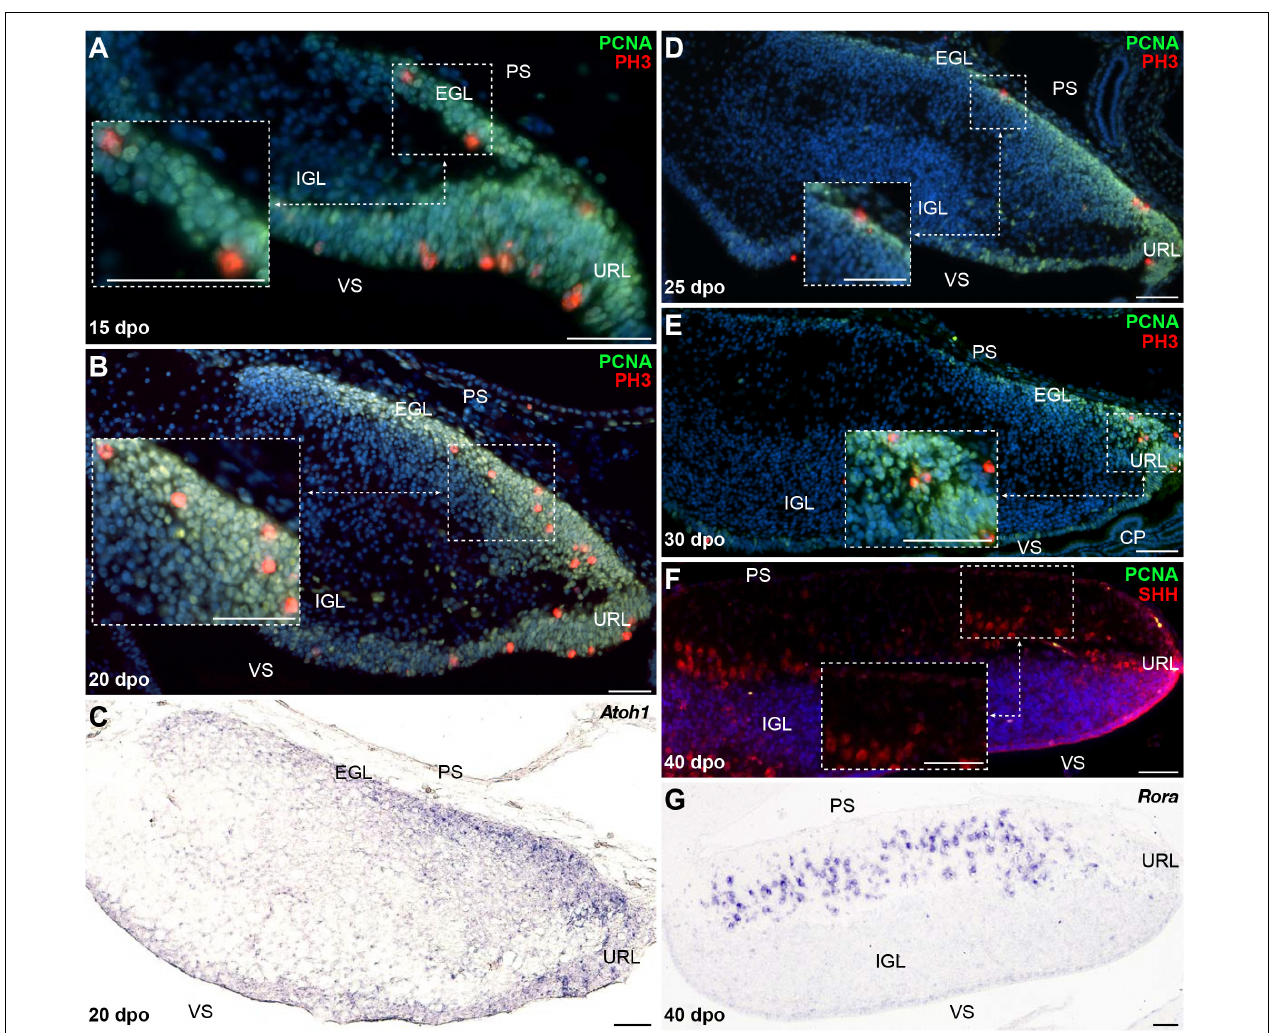
FIGURE 5 | Molecular characterization of GC patterning in B. fuliginosus . (A–E) Double IHC for PCNA (green staining) and PH3 (red) markers (A,B,D,E) or ISH for Atoh1 (C) at various indicated embryonic developmental stages between 15 and 30 dpo in the cerebellum of B. fuliginosus . Insets in panels (A,B,D,E) show high magnifications of mitotic progenitors on the pial surface. (F,G) Double IHC for PCNA (green) and SHH [ (F) ; red] or ISH for Rora (G) at 40 dpo. The inset in panel (F) shows high magnification of SHH-positive PCs. PS, pial surface; EGL, external granule layer; IGL, internal granule layer; VS, ventricular surface; URL, upper rhombic lip; CP, choroid plexus. Scale bars: 50 µ